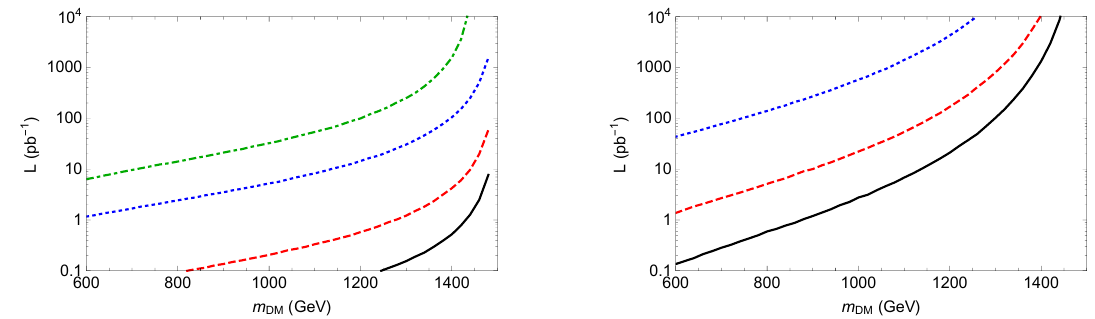
Figure 4 . Luminosity required for a 5 (cid:27) discovery for LLCPs with lifetime c(cid:28) = 10 m for fermions (left) and scalars (right). The di(cid:11)erent lines have the same representation as in (cid:12)gure 3. We see that for all fermion models but the doublet, as well as for the larger scalar multiplets, we can approach the kinematic limit 1.5 TeV with only a fraction of the design